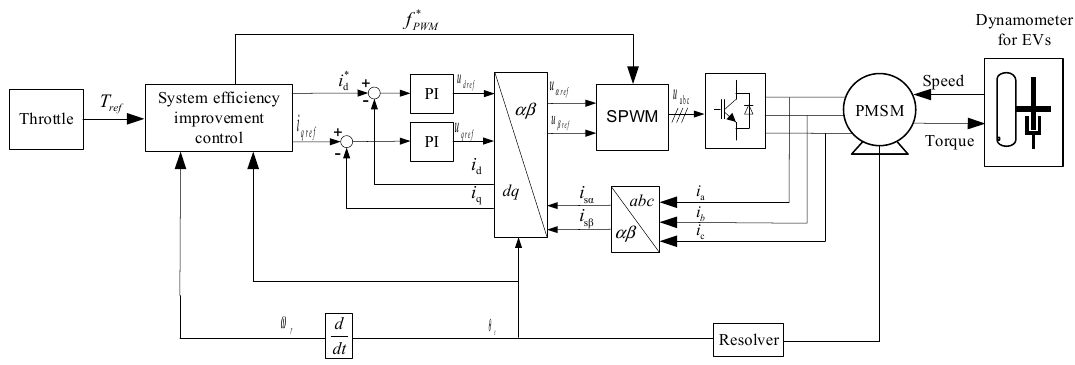
Figure 8. Structure diagram of the proposed system efficiency improvement control system.